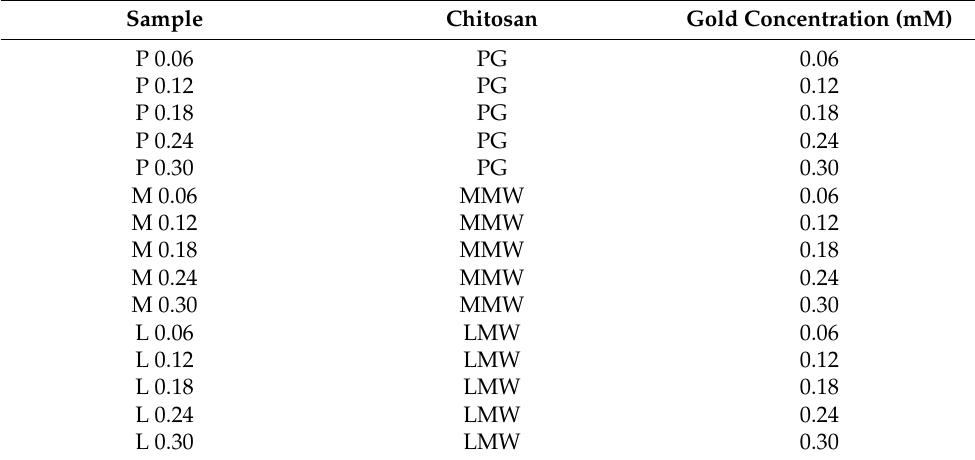
Table 1. The parameters of the samples. Sample